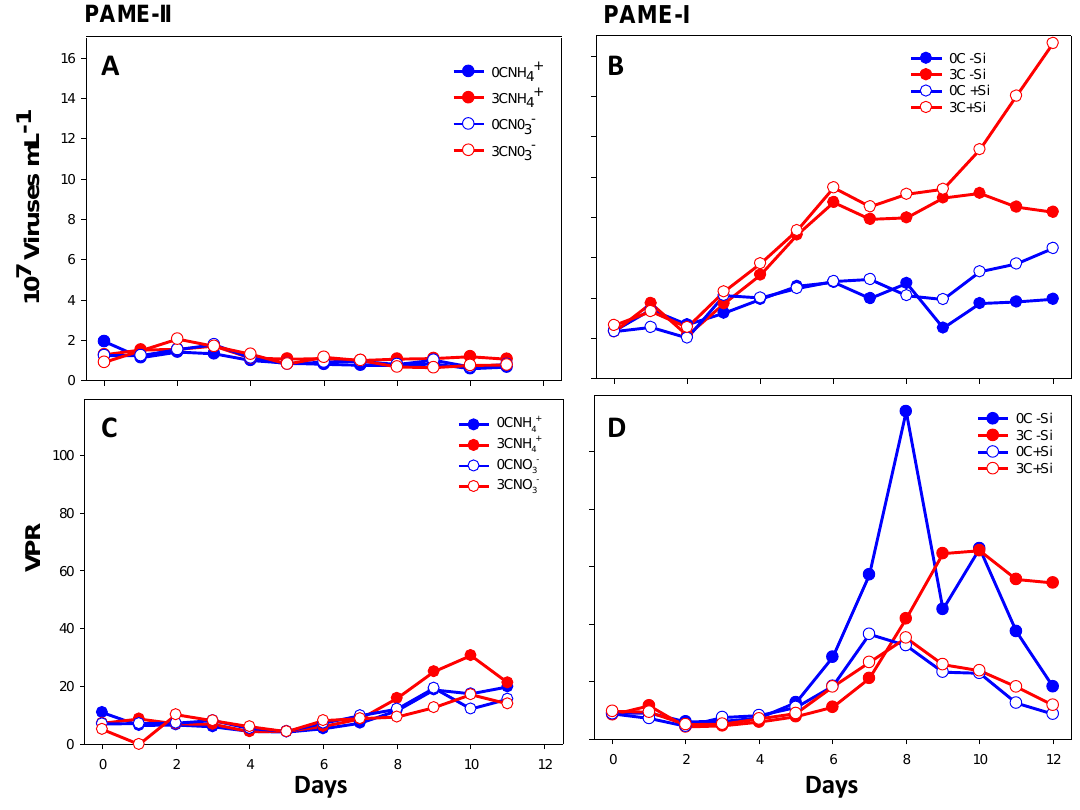
Figure 3. A and B, total abundance of viruses (all groups). C and D, virus to prokaryote ratio (VPR) determined by flow cytometry (FCM) of small viruses and prokaryotes. Blue circles show the data of tanks with no addition of carbon in the form of glucose, while red circles show three Redfield additions of carbon. Open and filled circles display perturbations with different nitrogen sources (open: NO 3 ; filled: NH 4 ) in PAME-II and with or without silicate (open: no Si addition; filled: Si addition) in PAME-I. See Figure 2 for more information about experimental design. Viral abundances during PAME-I have been previously published in Töpper et al.